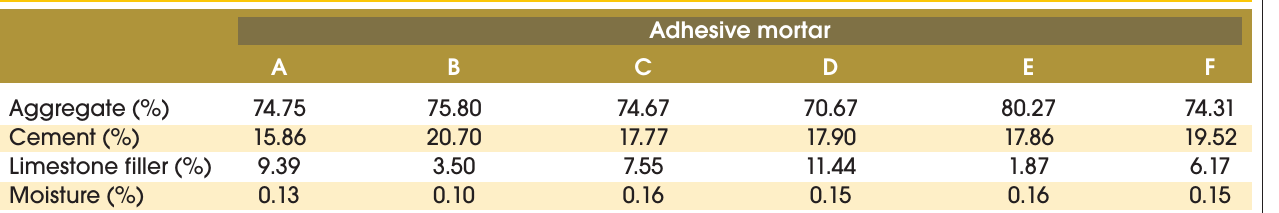
Table 2 – Reconstitution of the aproximation formulation of adhesive mortars